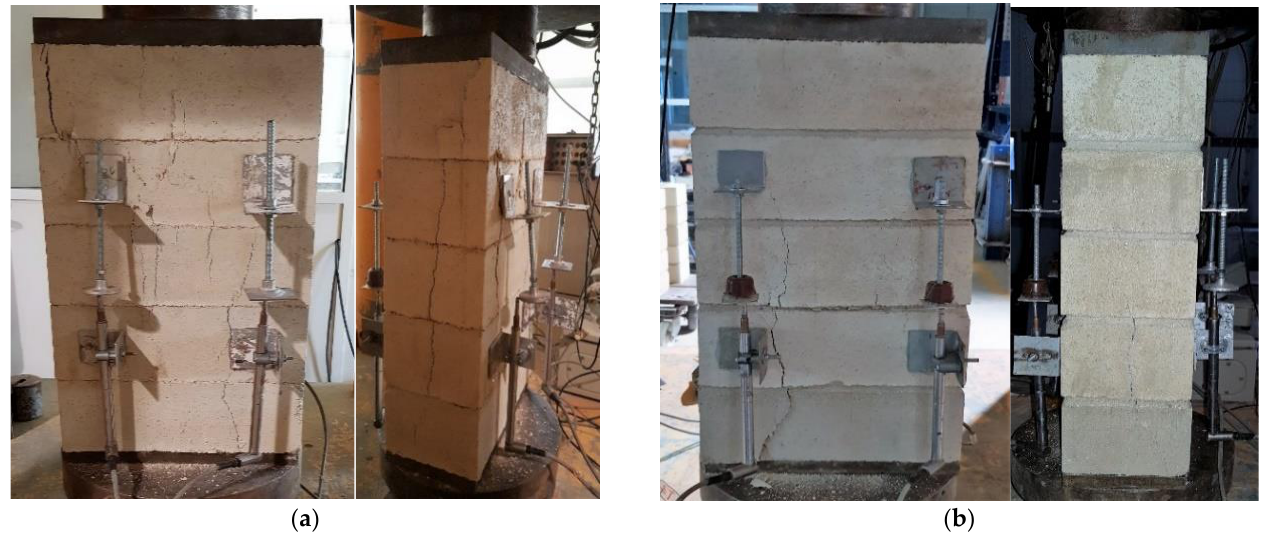
Figure 9. Failure mode of the prisms: ( a ) DSP and ( b ) MP.